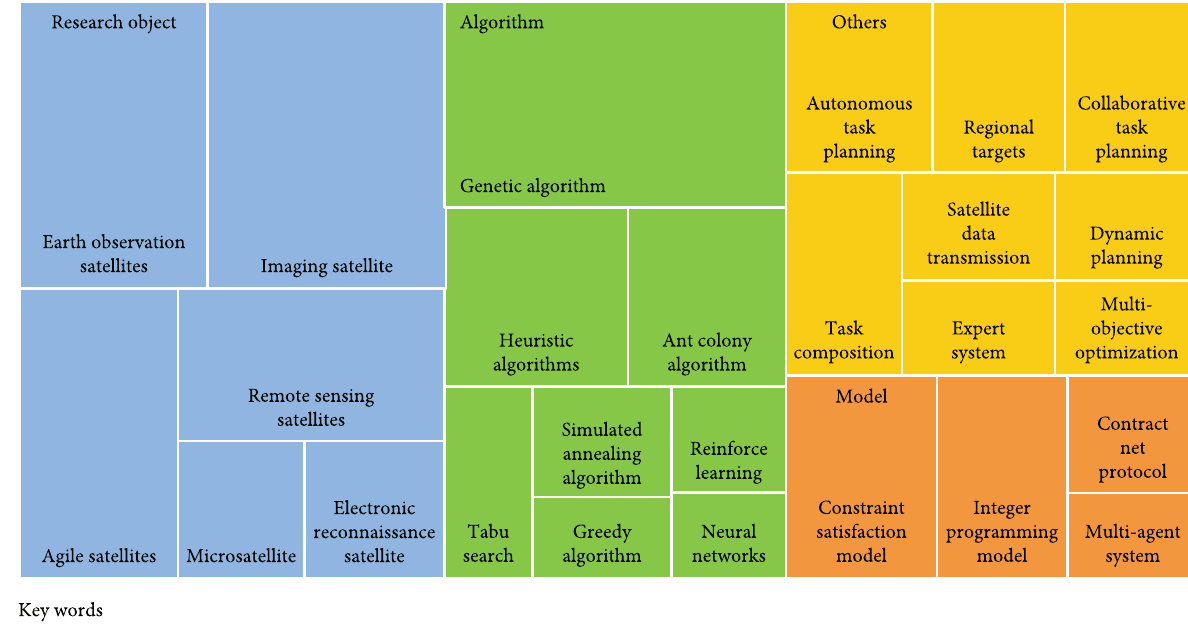
Figure 3: Article keyword frequency chart.